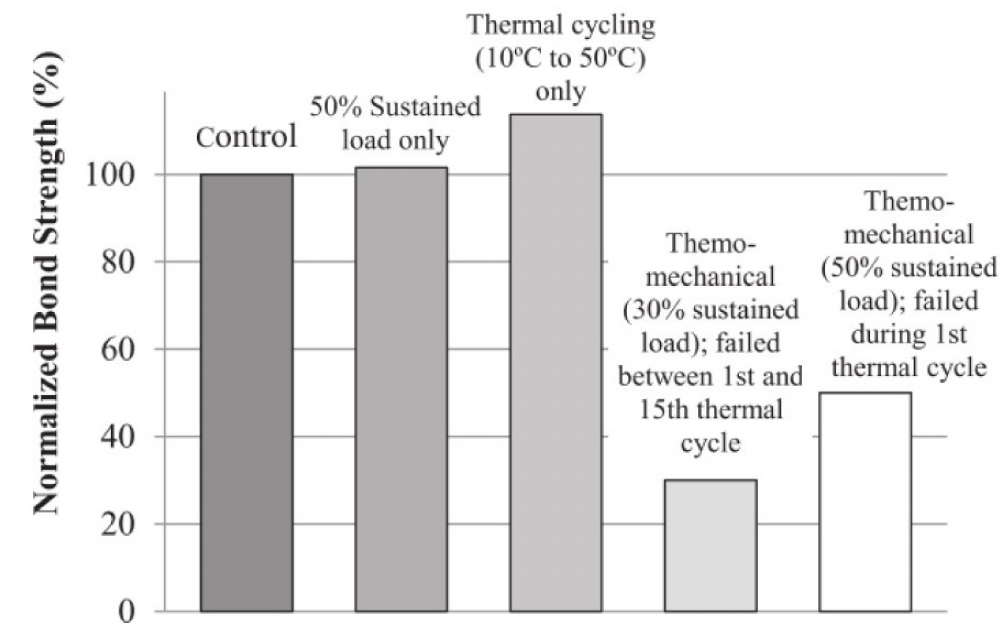
Figure 4. Bond strength behaviour of specimens under combined sustained load and thermal exposure [60]; used with permission from Composites Part B: Engineering, Elsevier,